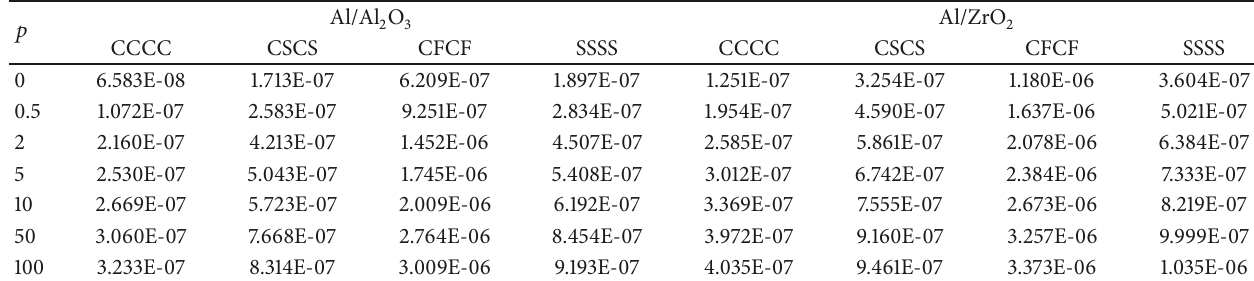
Table 7: Maximum deflection for FG plates having various boundary conditions with the uniform pressure in the part rectangular area [ (0.2,0.8), (0.5,1.5)